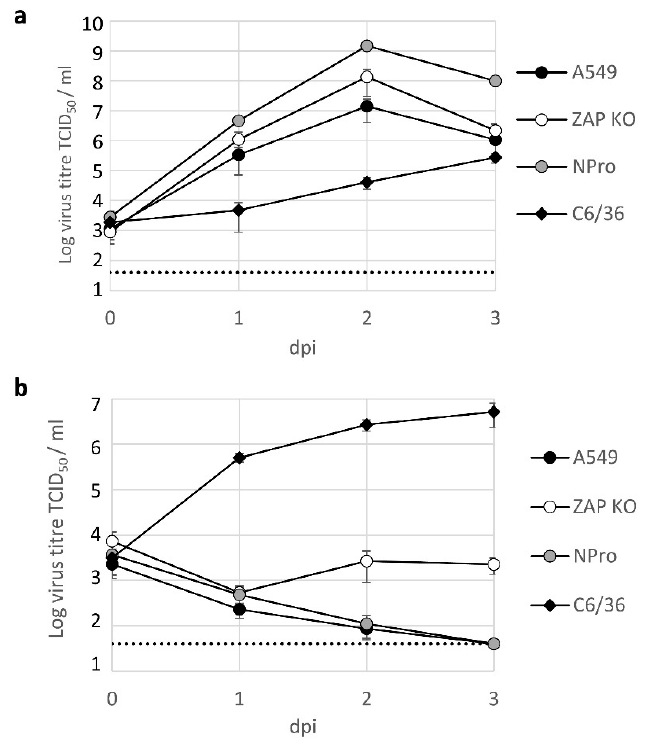
Figure 5. BinJV replication in ZAP k/o cells. Growth curves of USUV ( a ) and BinJV ( b ) in C6/36 mosquito cells (black diamonds), human A549 cells (black circles), A549 ZAP k/o cells (open circles) and A549 NPro cells (grey circles). Samples were taken on the indicated days post infection (dpi). Data points represent the average of independent biological experiments and error bars represent one standard error of the mean. Dotted line indicates the detection limit.